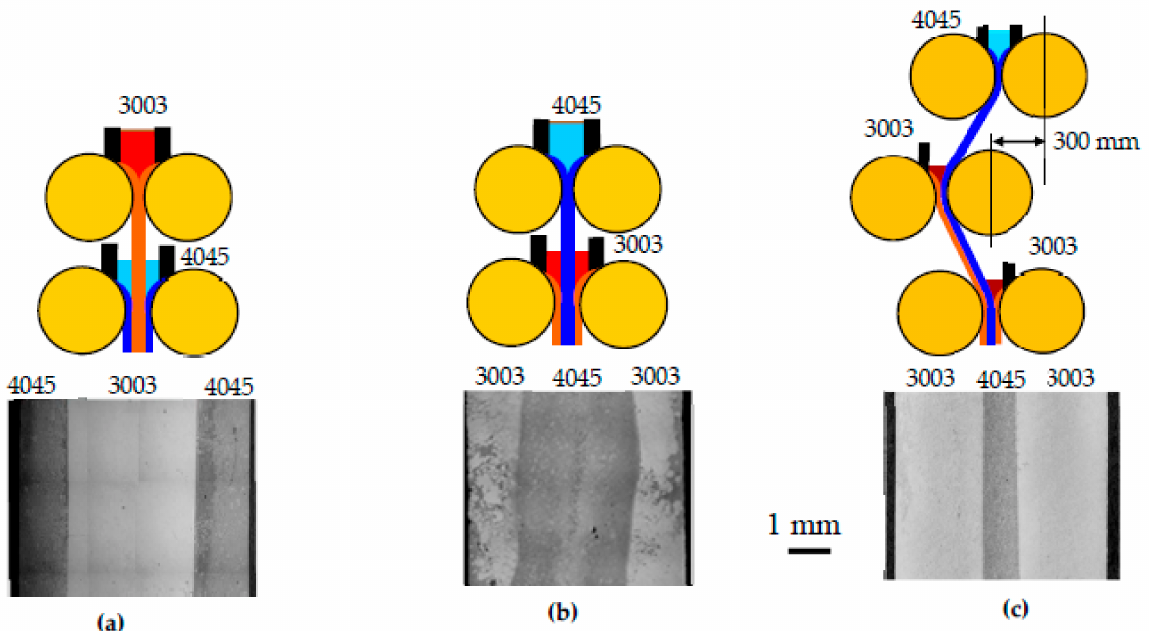
Figure 15. Schematic illustration of vertical-type tandem twin roll casters and cross-sections of clad strips. ( a ) 4045/ 3003/4045 clad strip, ( b ) 3003/4045/3003 clad strip, ( c ) 3003/4045/3003 clad